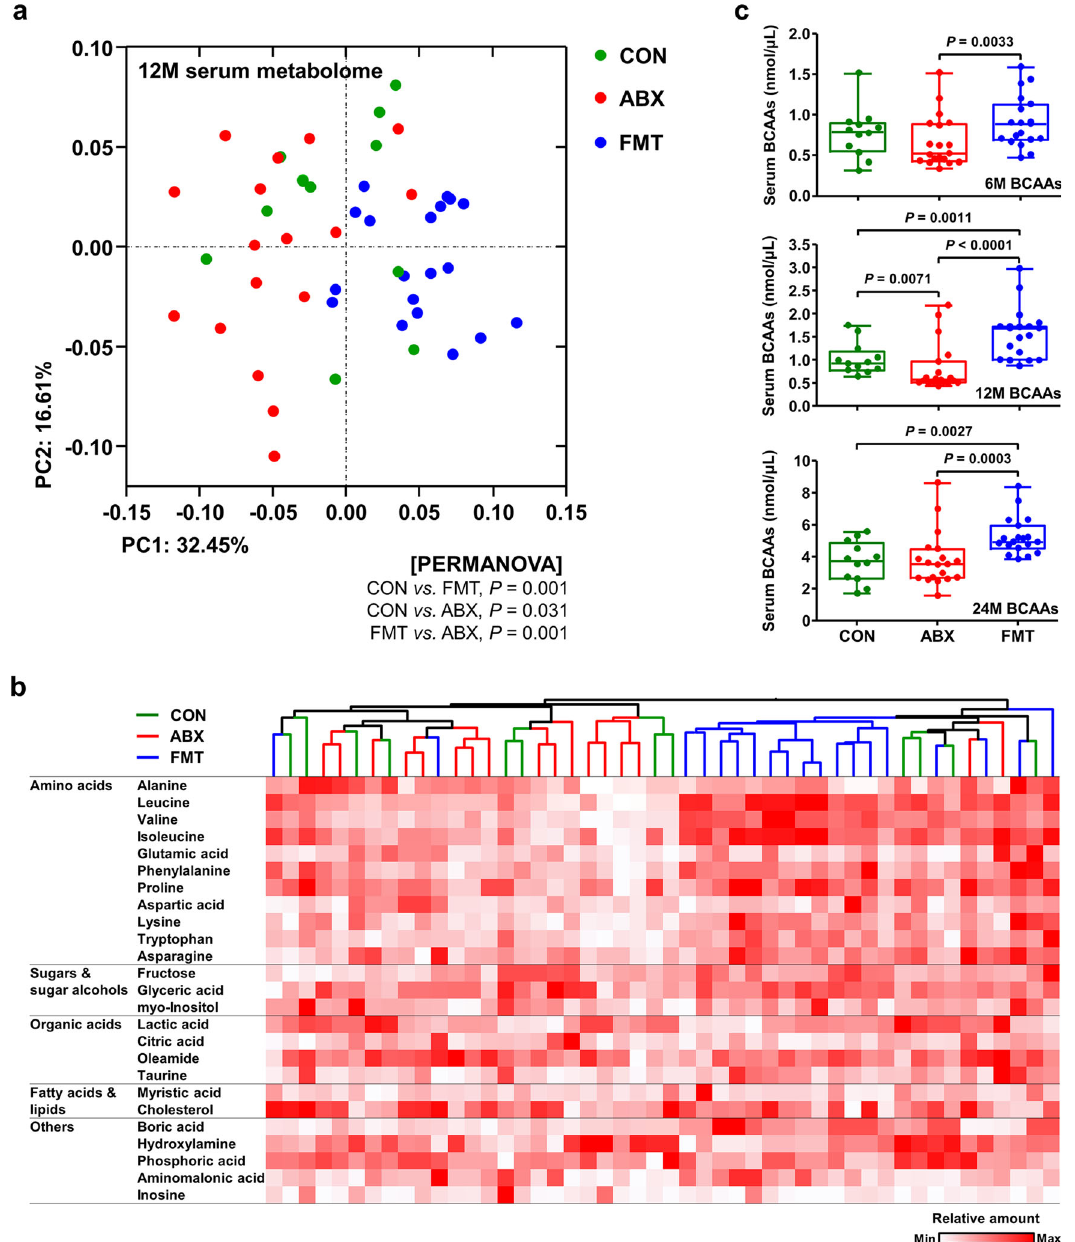
Fig. 6 Serum metabolome pro fi les of the 12-month-old cattle. a The serum metabolomes of the 12-month-old cattle ( n = 50) were analyzed using GC – TOF – MS and clustered using PCoA, based on the Bray – Curtis dissimilarity matrix. The data were analyzed using PERMANOVA, with 999 permutations. b The abundant serum metabolites in samples from 12-month-old cattle were clustered using the UPGMA dendrogram, based on the Bray – Curtis dissimilarity matrix, and the relative quantities are represented in a heatmap. Samples from the same groups are the same color. c Serum branched-chain amino acid (BCAA) concentrations in the 6- (upper, n = 50), 12- (middle, n = 50), and 24- (lower, n = 50) month-old cattle, quanti fi ed enzymatically and displayed as box and dot plots, as described in the “ Methods ” section. The lines, boxes, and whiskers in the box plots represent the median, and 25th, and 75th percentiles, and the min-to-max distribution of replicate values, respectively. Data are shown as mean ± SEM and were analyzed using the Mann – Whitney U test (two-tailed). BCAAs, branched-chain amino acids. Source data are provided as a Source Data fi